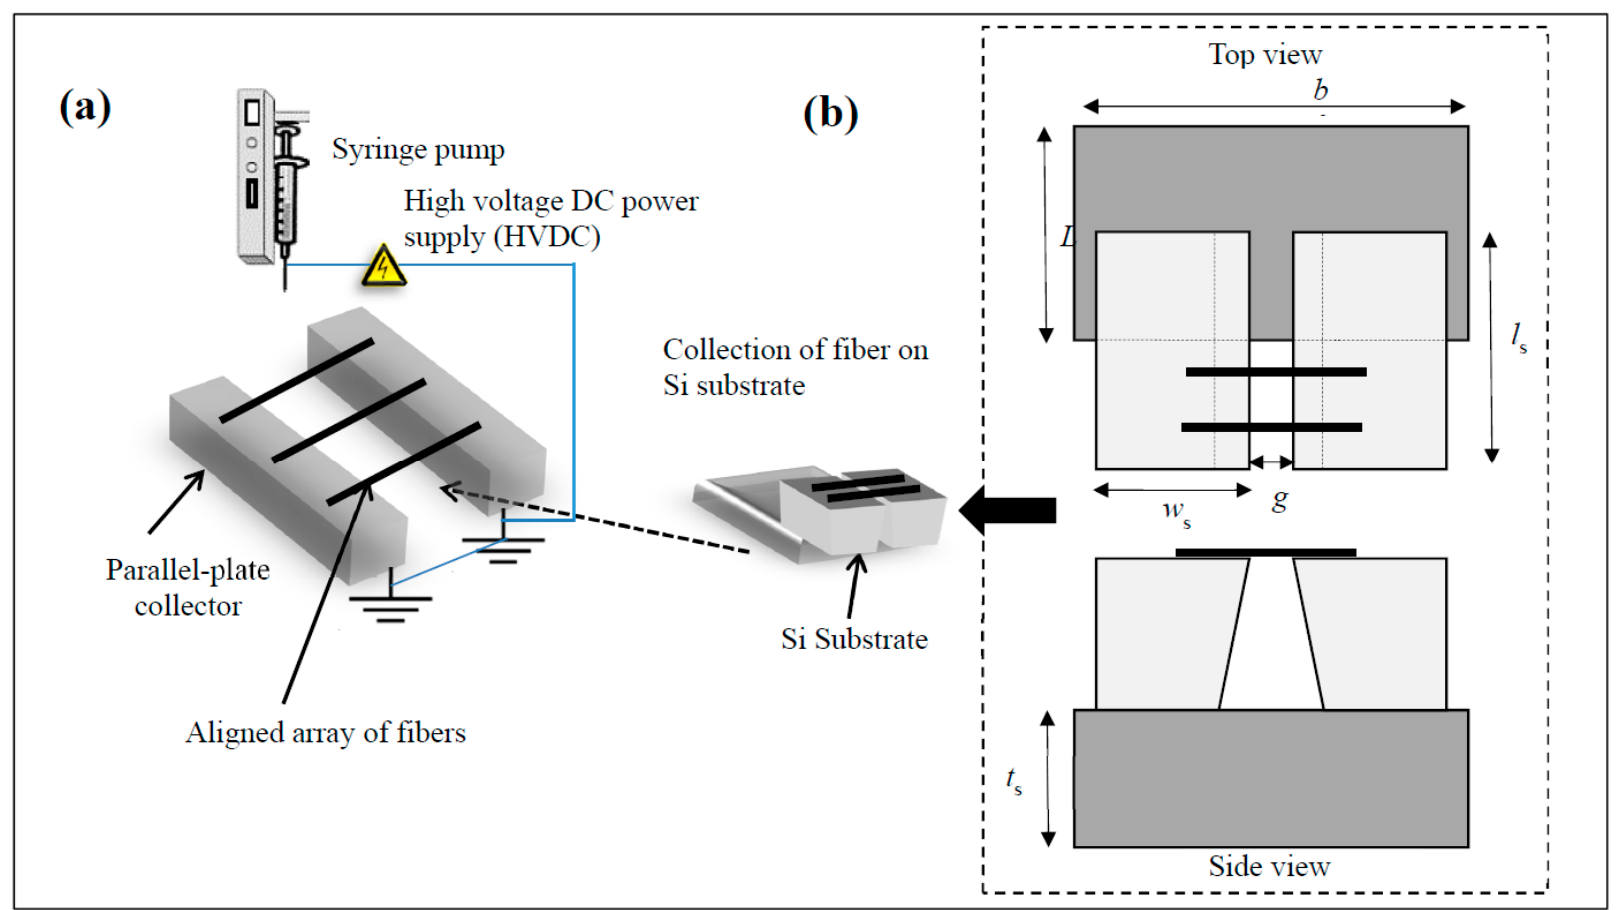
Figure 1. ( a ) Schematic of the electrospinning setup employed to collect uniaxially aligned poly(vinylidene fluoride) (PVDF) electrospun fibers; ( b ) schematic of the custom designed substrate employed to collect individual electrospun fibers. Here, w s ~ 5 mm, l s ~ 10 mm, t s ~ 0.5 mm, b ~ 12 mm, and L ~ 10 m.